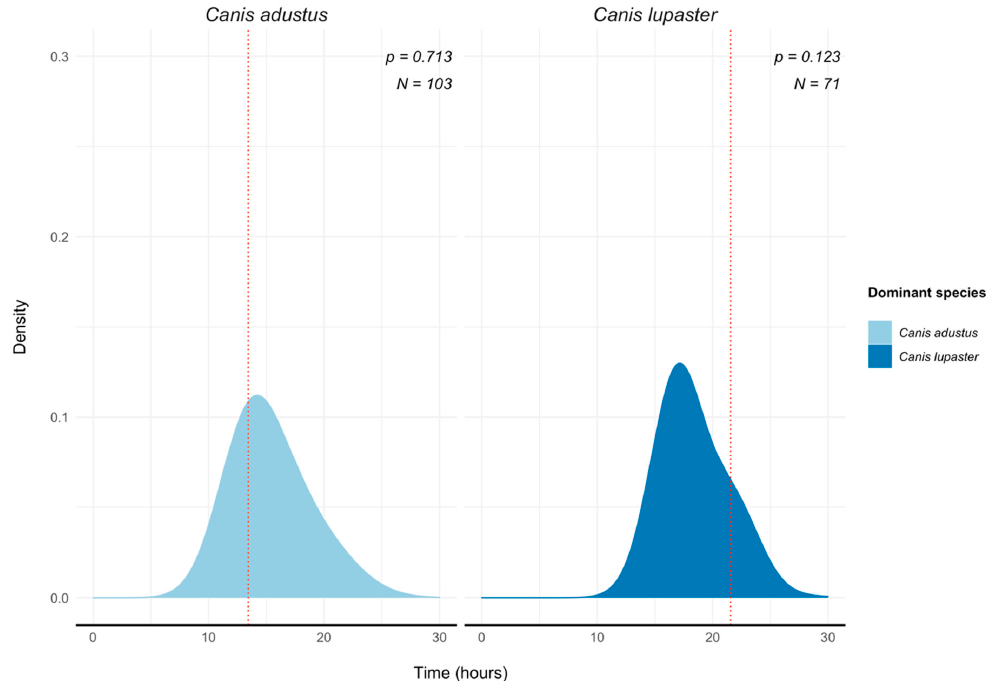
Figure 4. Time-to-encounter analysis between African wolves (dark blue) and side-striped jackals (light blue) at artificial waterholes in the Ferlo region (Senegal). Vertical lines represent median minimum time-to-encounter of the other species. Shaded areas represent simulated expected distributions.